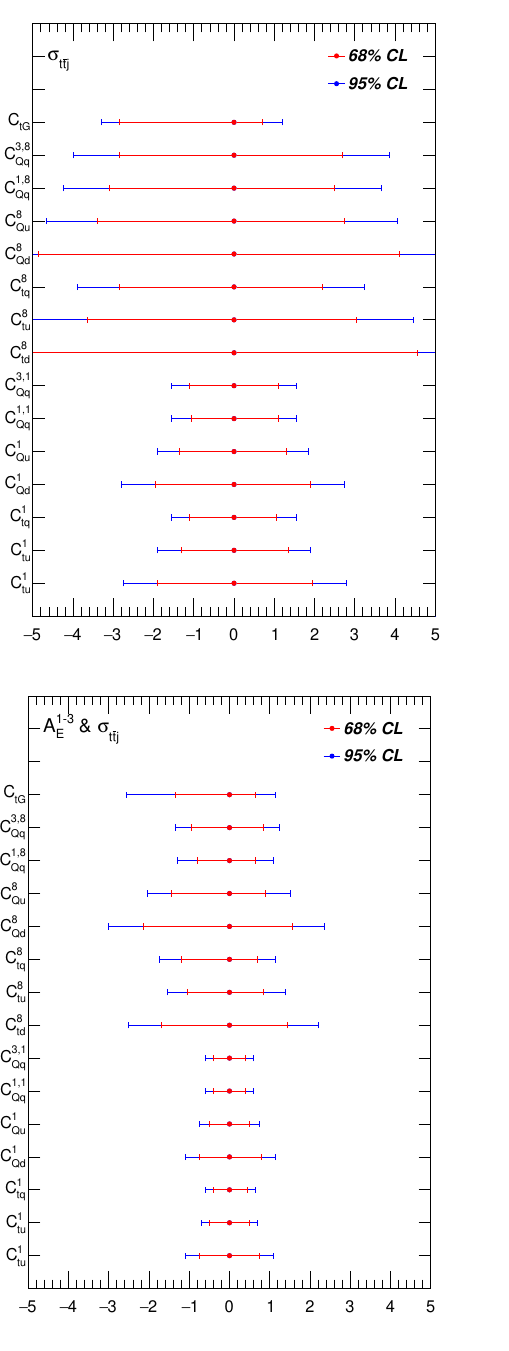
Figure 5 . Expected bounds on individual Wilson coe(cid:14)cients from LHC Run-2 measurements of the cross section (cid:27) in the boosted regime (top left), the combination of optimized energy asymmetries t (cid:22) tj A 1 , A 2 , A 3 in all three (cid:18) j bins (top right), and a combination of these four observables (bottom E E E left). For comparison, we show existing bounds from the rapidity asymmetry in t (cid:22) t production as measured during Run 2 [29] (bottom right). The bounds on C i are reported in units of TeV (cid:0) 2 .